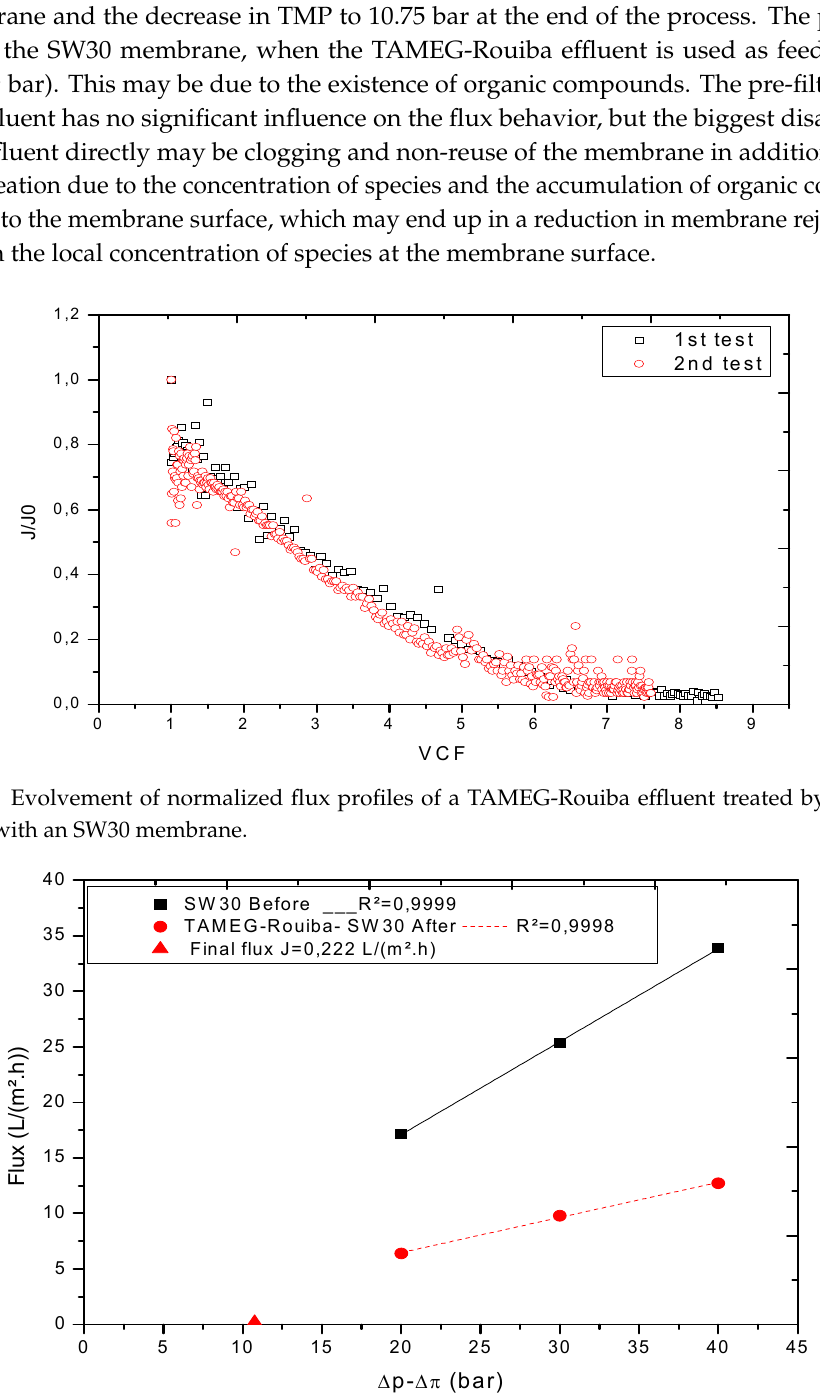
Figure 4. Volumetric permeate flux as a function of transmembrane pressure (TMP).